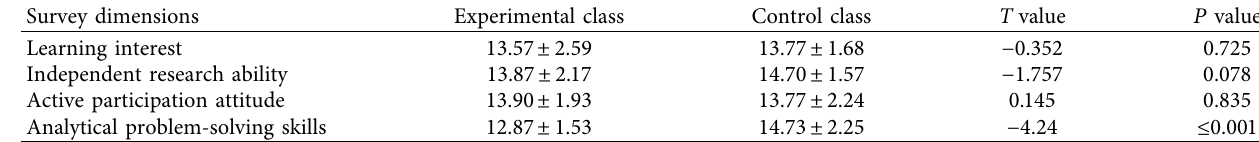
Table 2: Comparative analysis of students’ martial arts learning situation in the two classes before and after the experiment.